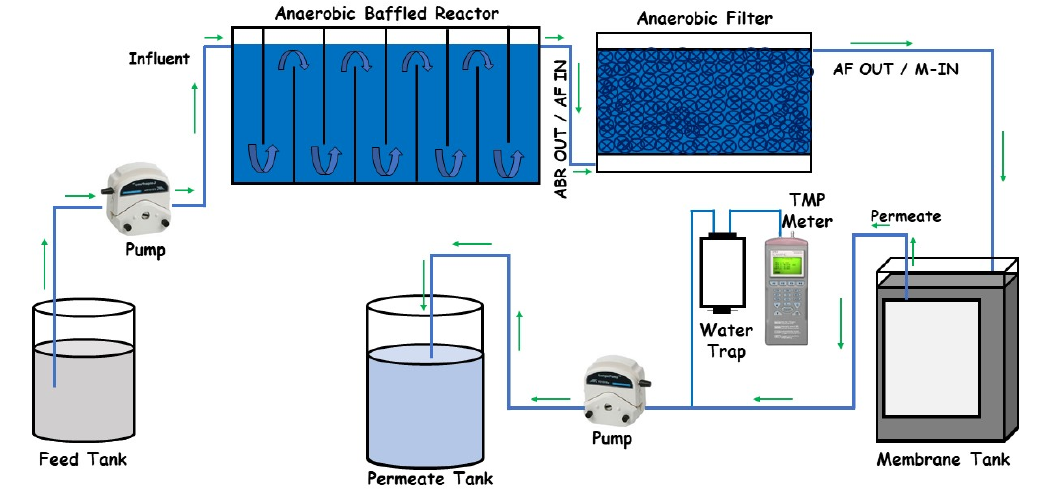
Figure 1. Process flow diagram of decentralized wastewater treatment system.